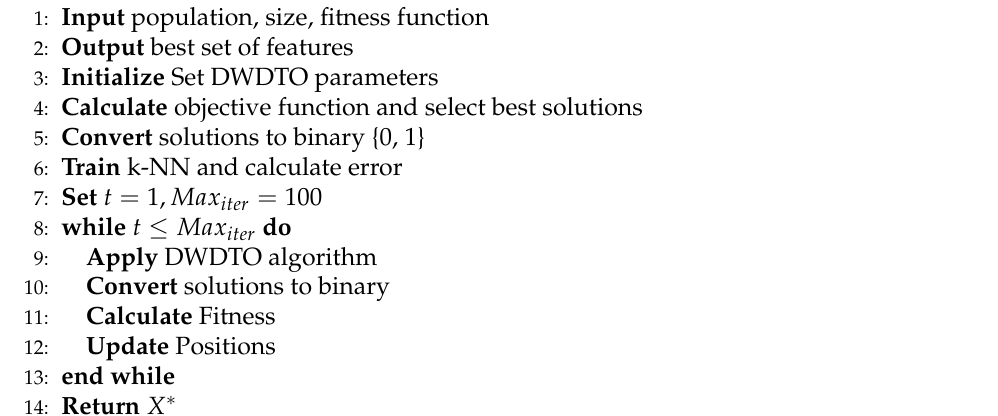
Algorithm 3 The proposed feature selection algorithm (binary